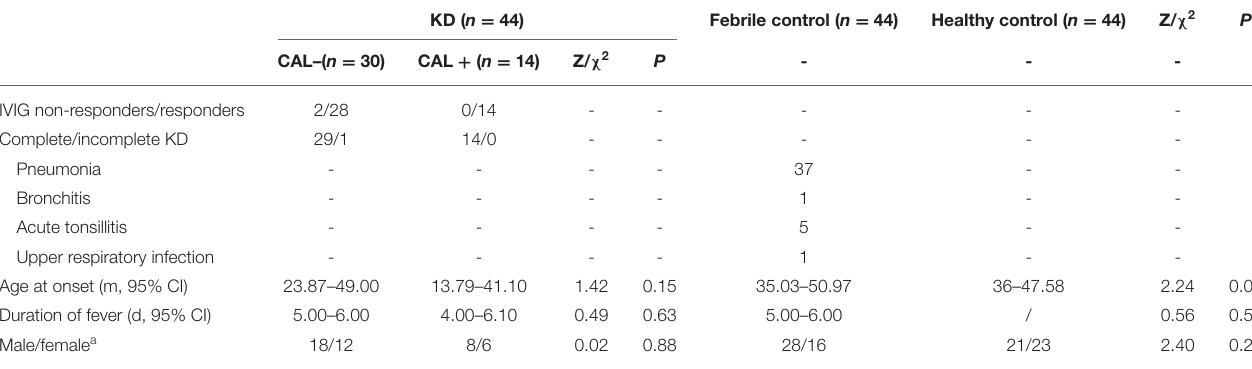
TABLE 1 | Demographic data of Kawasaki disease (KD) patients and two control